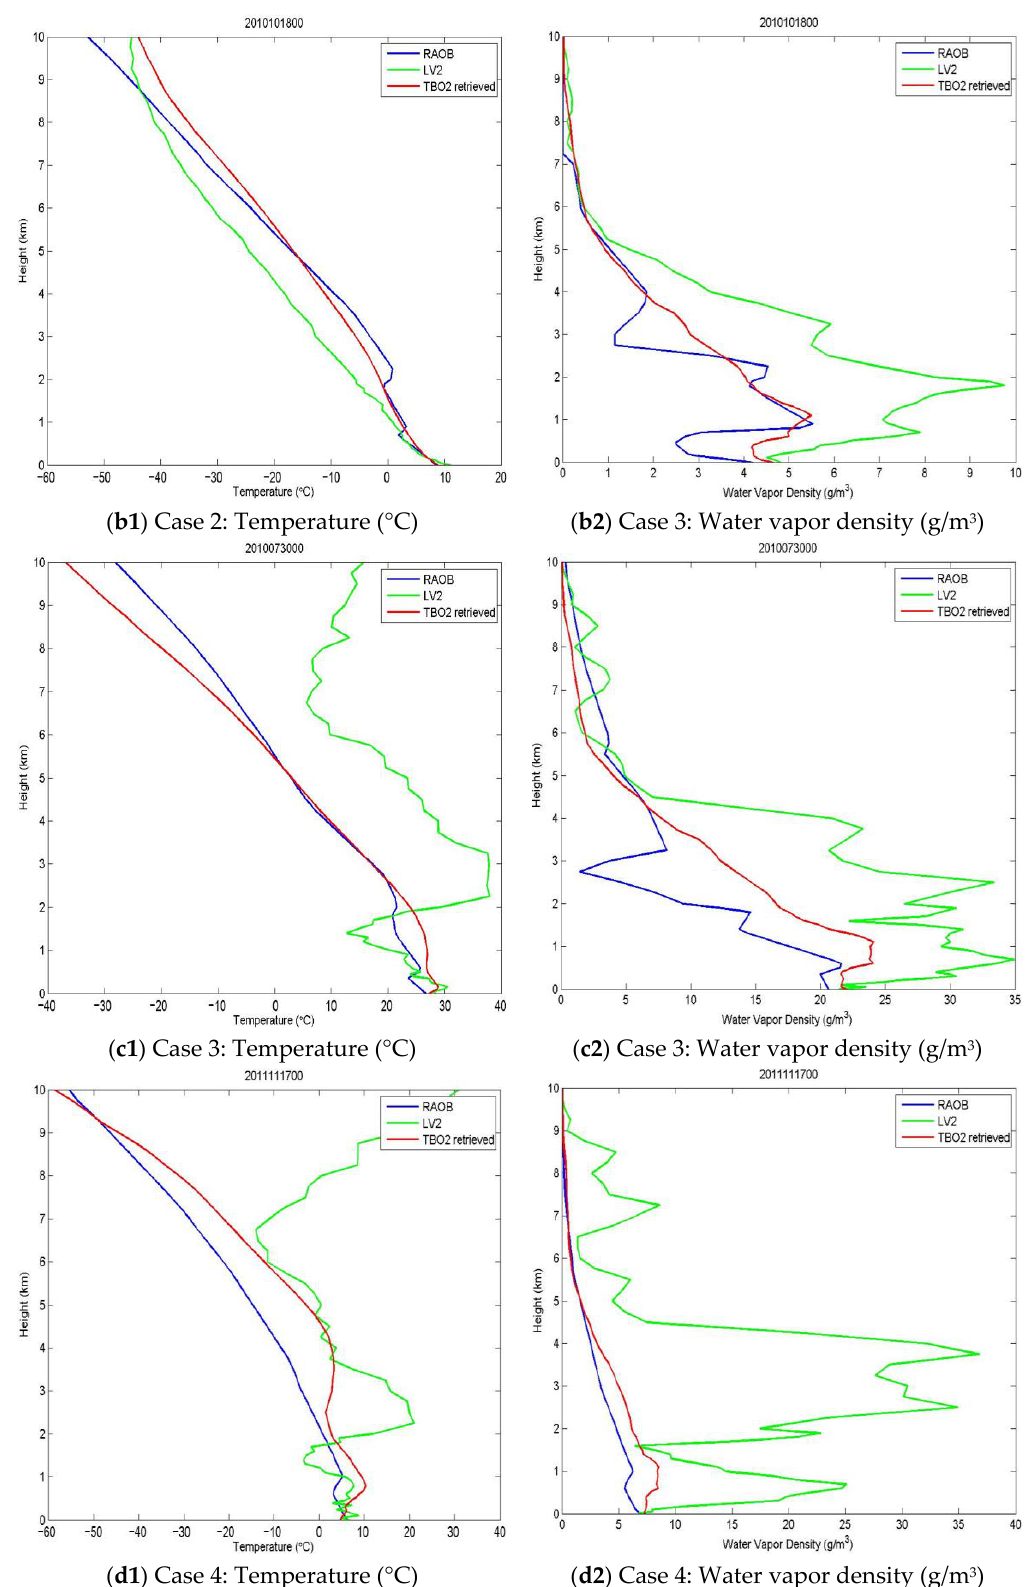
Figure 4. Comparison of atmospheric temperature ( left panels) and humidity ( right panels) profiles from this study (red curves) and LV2 products (green lines) with RAOB (blue lines) for the four typical cases. ( a ) Case 1 at 00:00 UTC on 17 November 2010; ( b ) Case 2 at 00:00 UTC on 18 November 2010; ( c ) Case 3 at 00:00 UTC on 30 July 2010; ( d ) Case 4